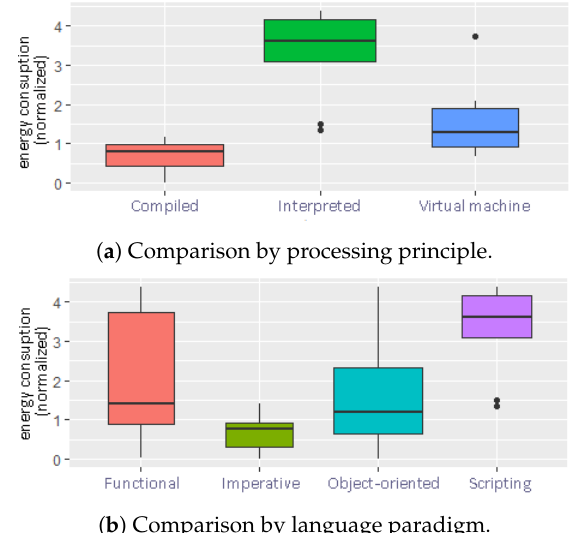
( a ) Comparison by processing principle.